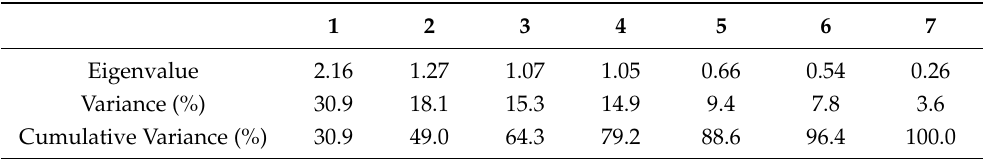
Table 3. Eigenvalues of correlation matrix, and related statistics. Percentage of variance for each component (initial eigenvalues).